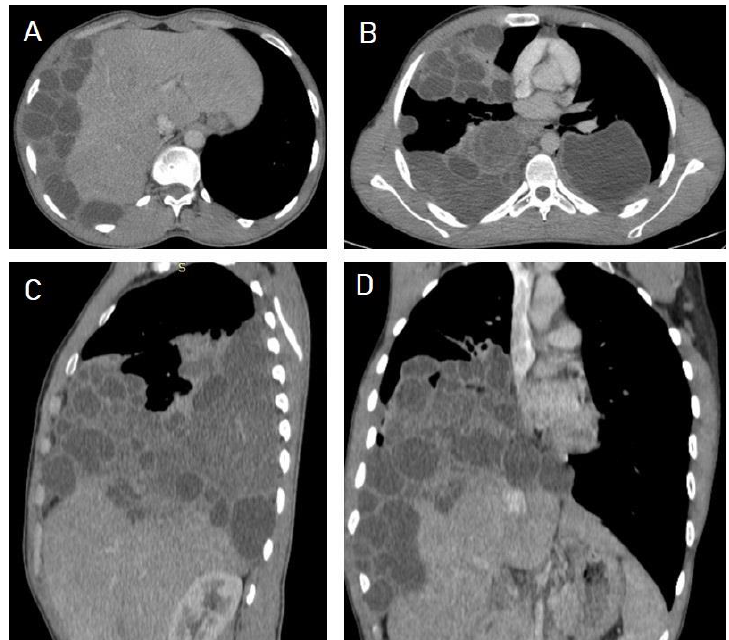
Figure 15. Selected CT images of a 40-year-old male presenting with cough and dyspnea showing a ruptured liver hydatid cyst complicated with disastrous dissemination into the peritoneal cavity seen on the axial section ( A ), and bilateral chest seeding seen on axial ( B ), sagittal ( C ), and coronal ( D ) sections. Picture is in keeping with peritoneal and bilateral chest seeding from the liver hydatid cyst.